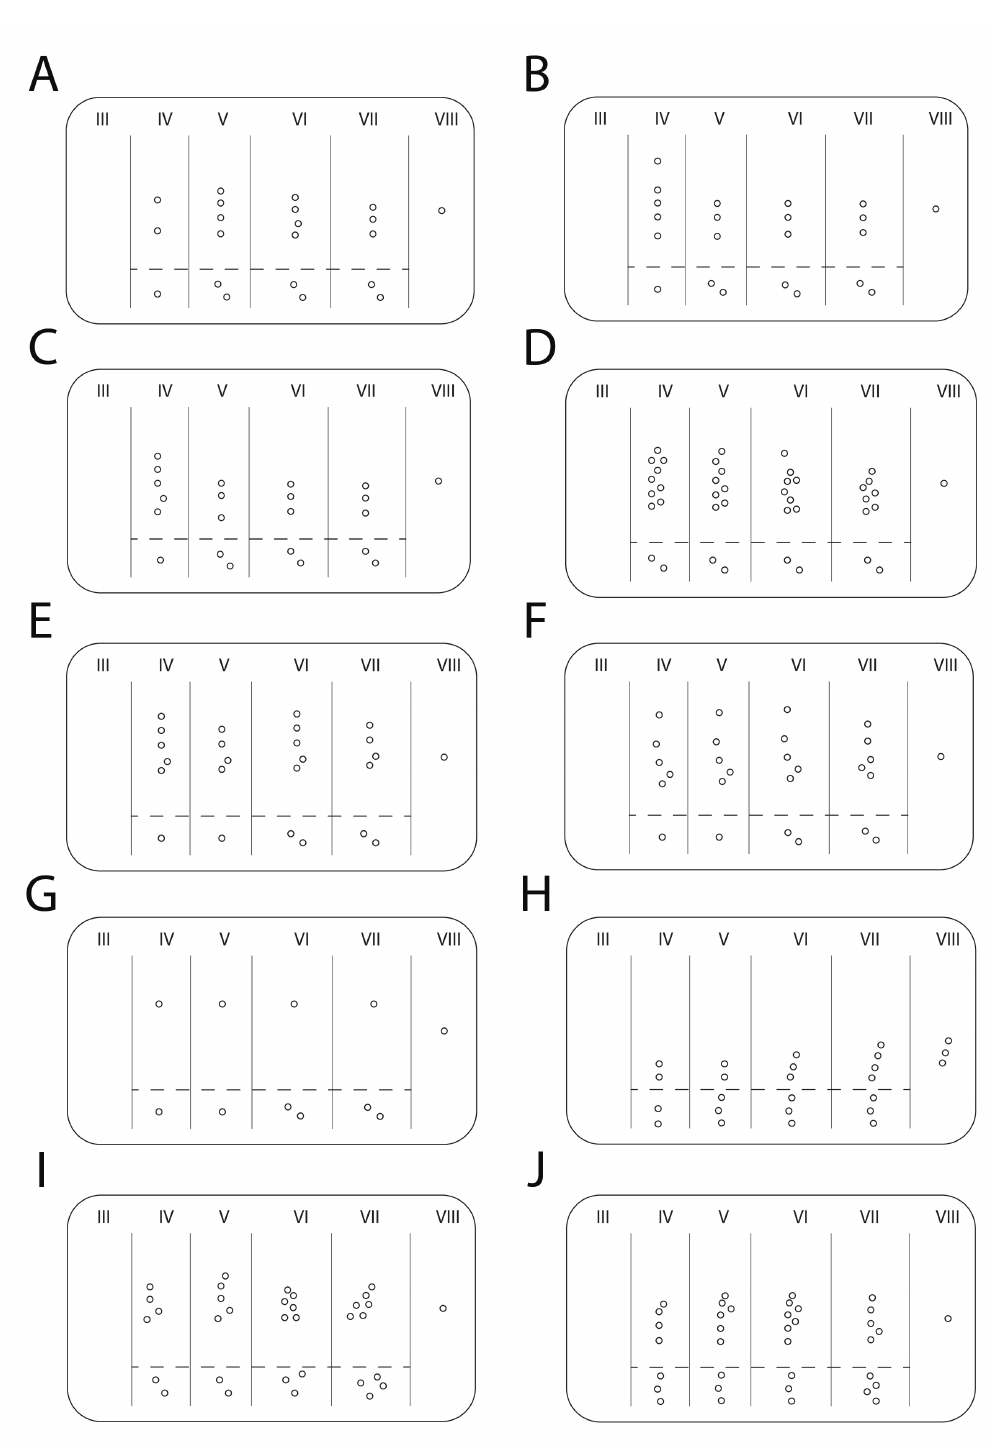
Fig. 26. Scheme of lateral abdominal sensory pit arrangement of Caliscelidae. Roman numerals refers to abdominal tergite number and sensory pits below the dashed line are the isolated ones. A .